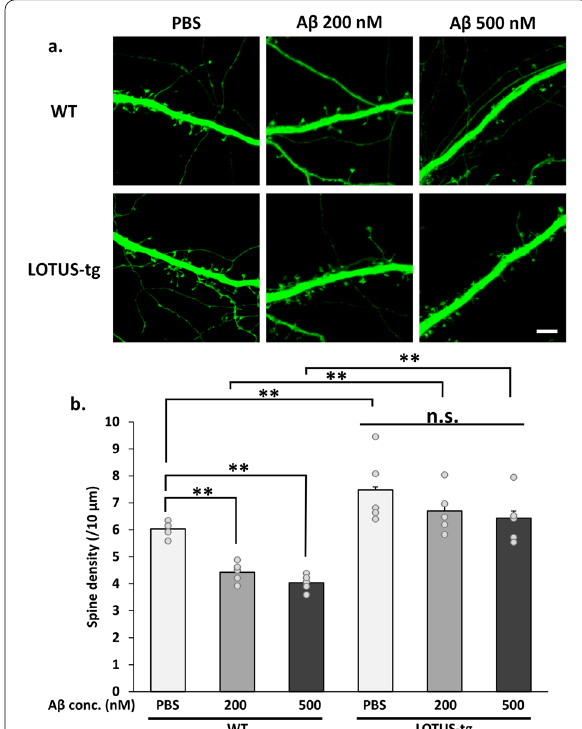
Fig. 3 LOTUS overexpression suppresses Aβ-induced decrease of spine density. a Representative images of dendritic spines of cultured hippocampal neurons from WT or LOTUS-tg mice after 48 h of treatment with Aβ. Scale bars, 5 μm. b Quantification of spine density of each dendrite per 10 µm. The data are presented as mean from five independent cell culture preparations (n were analyzed at each experiment, Two-way ANOVA post hoc Tukey test * p < 0.05, ** p <